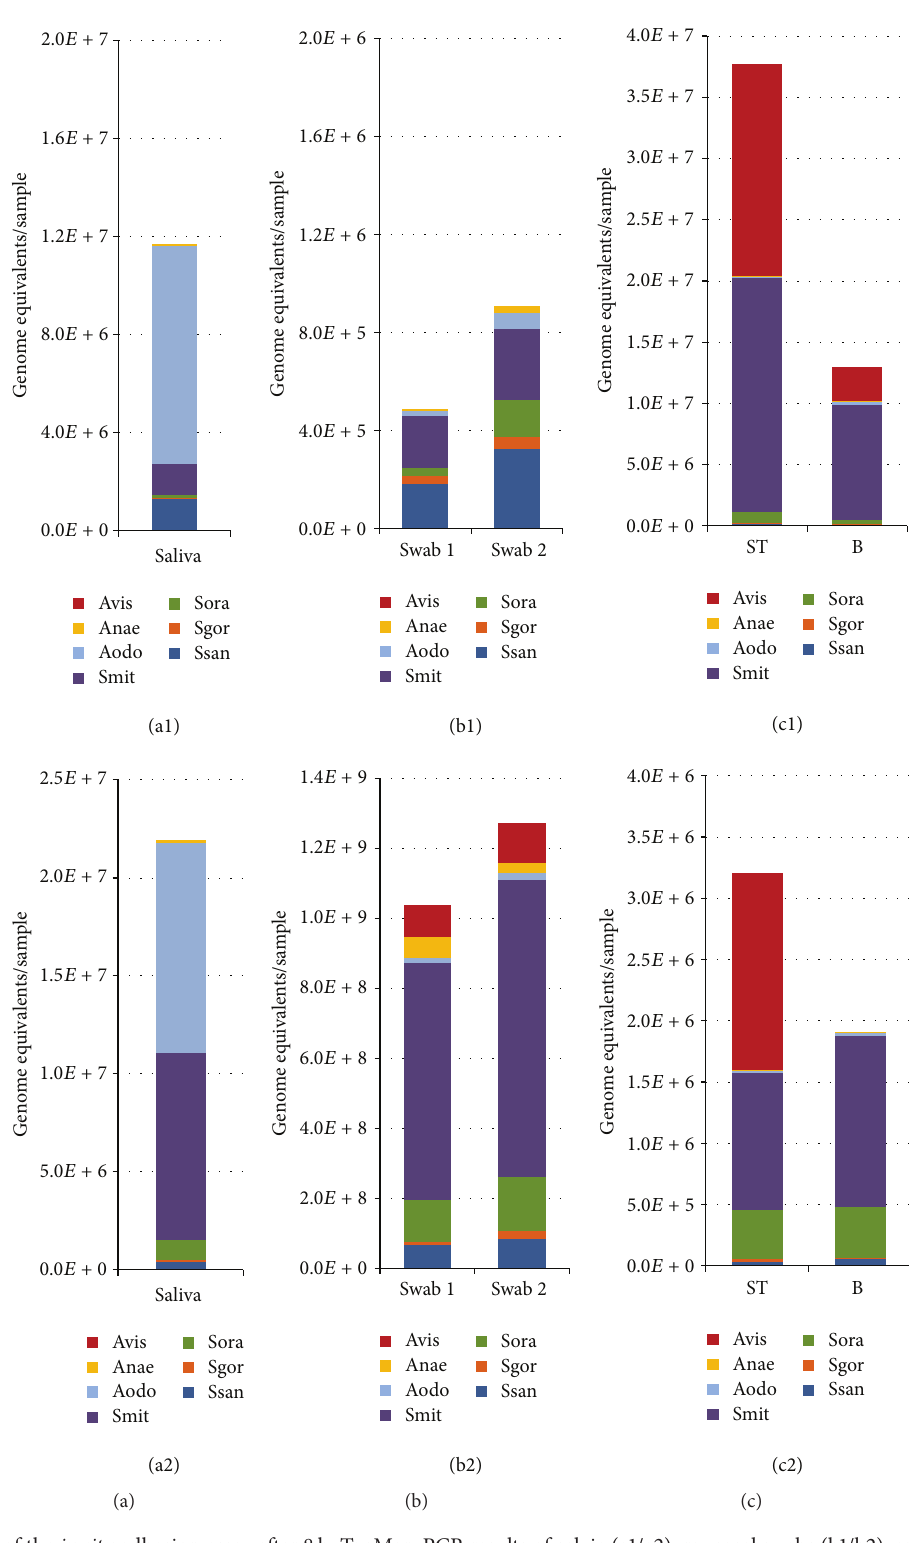
Figure 2: Results of the in situ adhesion assay after 8h. TaqMan-PCR results of salvia (a1/a2), mucosal swabs (b1/b2), and the amount of A. viscosus (Avis), A. naeslundii (Anae), S. mitis (Smit), S. oralis (Sora), S. gordonii (Sgor), and S. sanguinis (Ssan) (c1/c2) after 8 h on ST and material B for volunteers 1 (a1, b1, and c1) and 2 (a2, b2, and